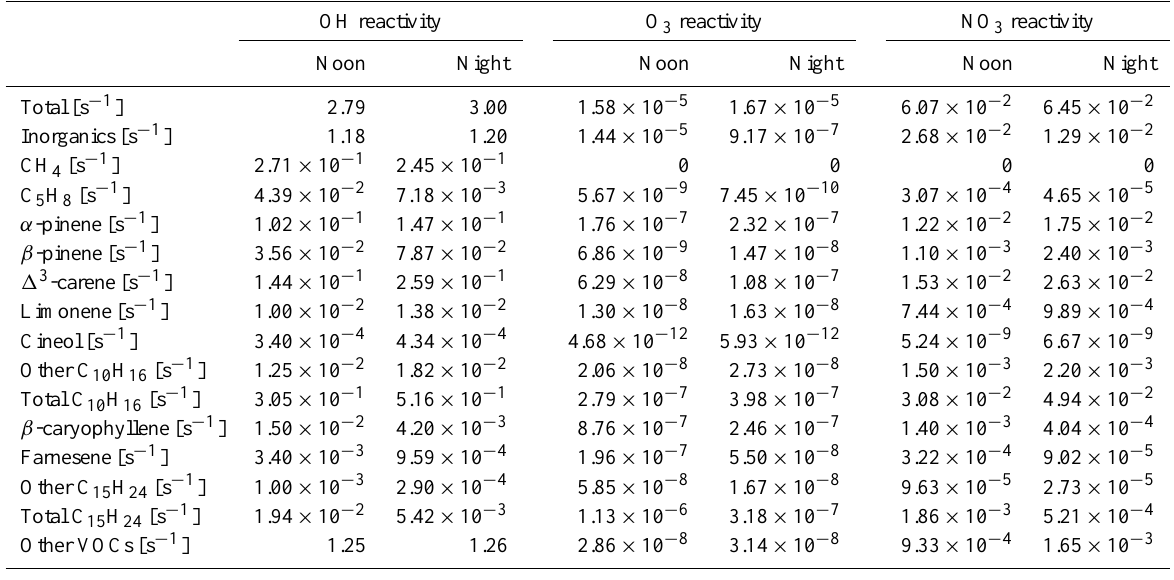
Table 3. Time-dependent contribution to the investigated instantaneous reactivities. The contribution distributions and total reactivities are given as means for 18m at noon and at night (2a.m.) for the OH, O 3 and NO 3 reactivity. The contributions are given with respect to inorganic compounds (see Sect. 7.4 for which compounds are included), methane (CH 4 ), isoprene (C 5 H 8 ), total and individual monoterpenes (C 10 H 16 ) and sesquiterpenes (C 15 H 24 ) (see Sect. 5.4) together with the resisting organic compounds that the three oxidants are reacting with (see Sect. 7.4 for how many compounds this includes).